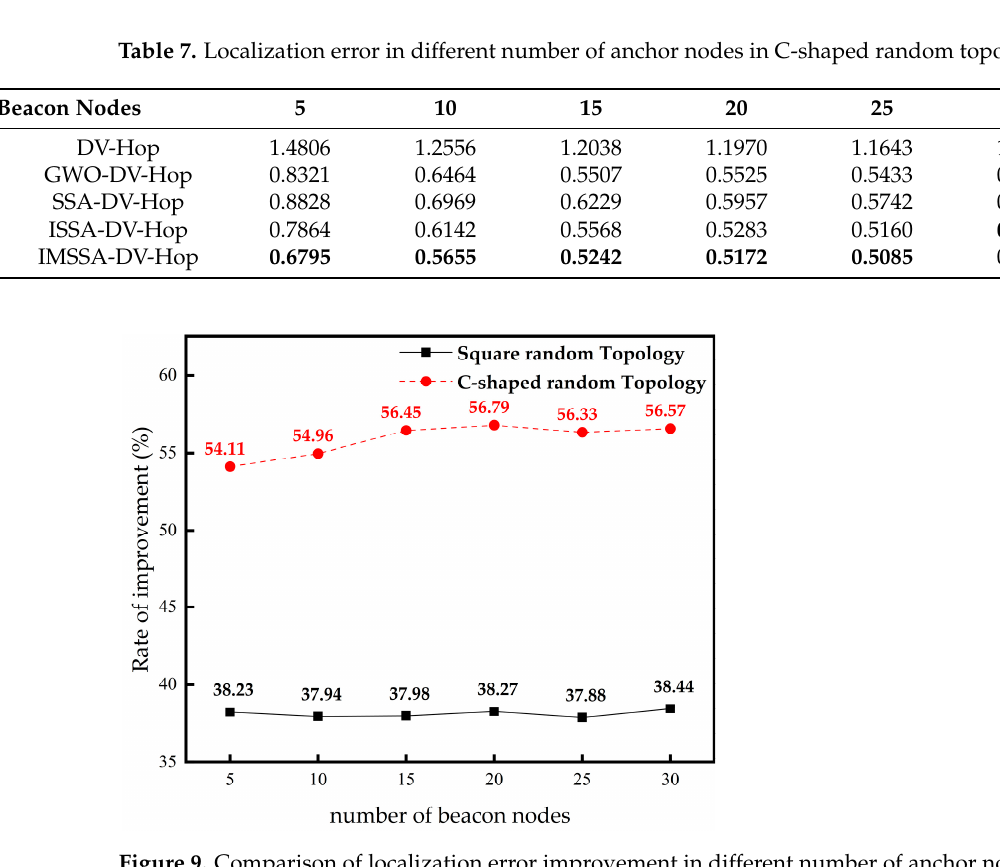
Table 6. Localization error in di ff erent number of anchor nodes in square random topology